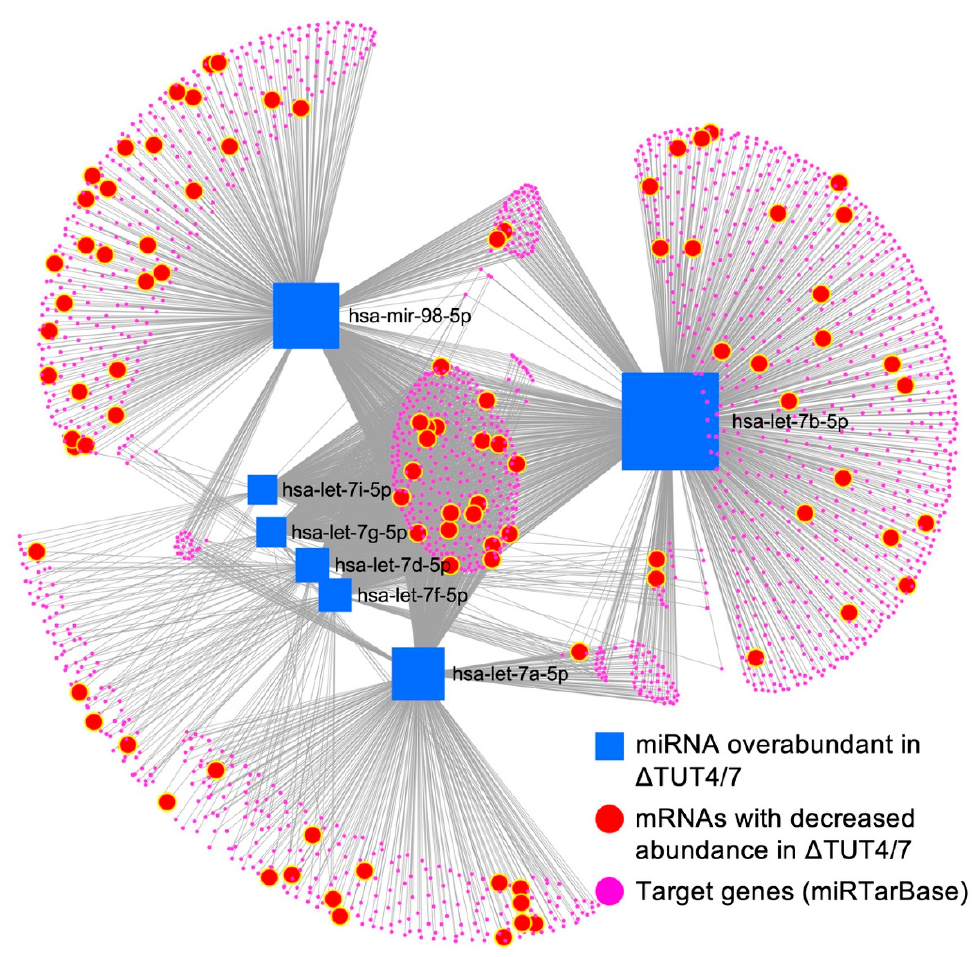
Figure 5. The miRNA–mRNA interaction network reveals target distribution among 1933 target mRNAs (pink circles) of the upregulated let-7 miRNAs (blue squares), 94 are downregulated at least two-fold (highlighted in bigger red circles) in Δ TUT4/7 HEK 293T cells. The miRNA–target interaction is based on experimentally validated information obtained from miRTarbase v8.0. The diagram was generated using miRNet 2.0.